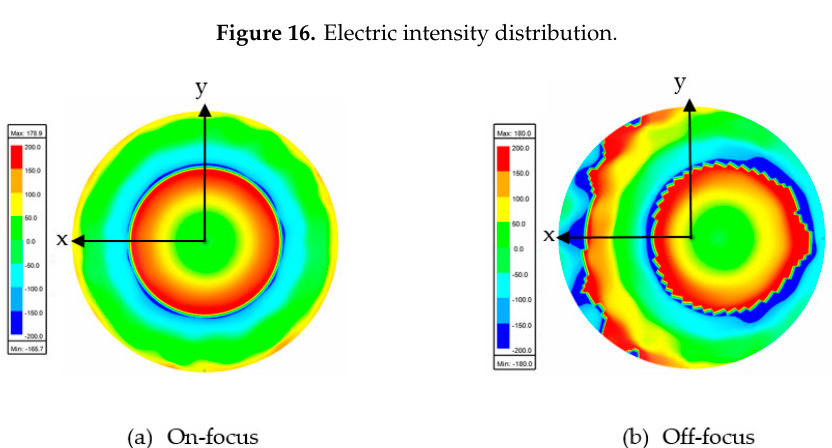
Figure 16. Electric intensity distribution.